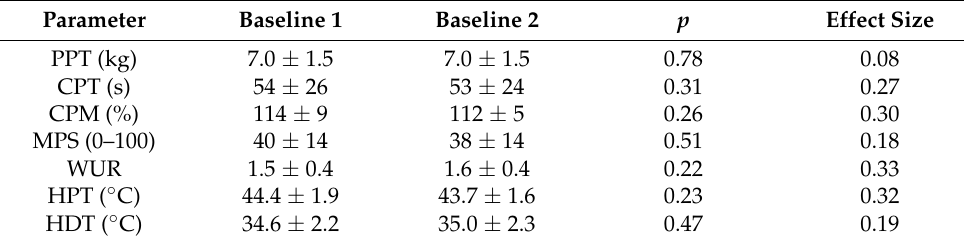
Table 3. Baseline